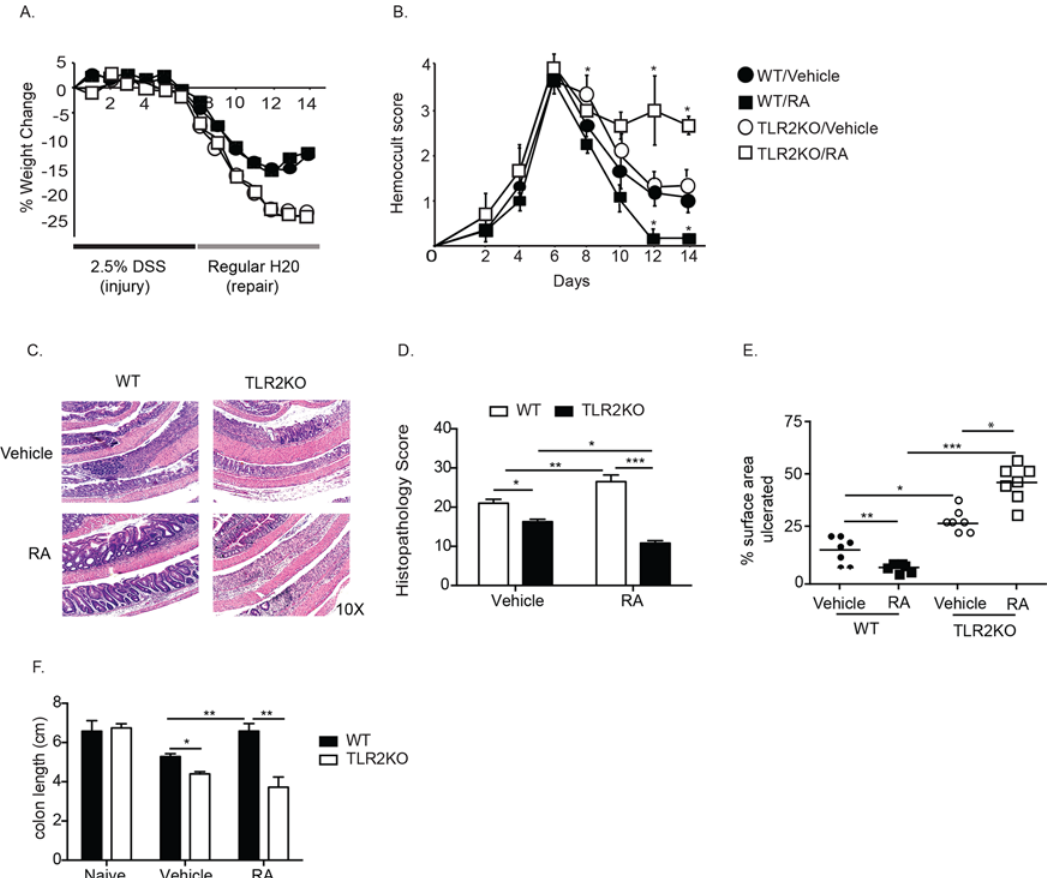
Fig 1. RA potentiates colonic injury and inflammation in the absence of TLR2 signaling. WT and TLR2KO mice were given 2.5% DSS for seven days to induce colonic damage and then placed on normal drinking water for seven days to allow for tissue repair. Upon first presence of fecal occult blood positivity for each, mice were supplemented with RA or vehicle control, which continued for the rest of the disease course. Weight loss (A) and fecal occult blood (B) (n = 10 – 14 mice per group) were monitored daily. (C) H&E staining of colonic sections of mice at day 14 (after 7 days of DSS followed by 7 days of water). (D) Histology scoring of H&E-stained colonic slides (n = 4 mice per group). (E) The percent of surface area containing ulcerated/denuded epithelium quantified using J Image software. (F) Colon lengths from mice at day 10 (n = 5 – 6 mice per group). * , p < 0.05, ** , p < 0.01 using Students